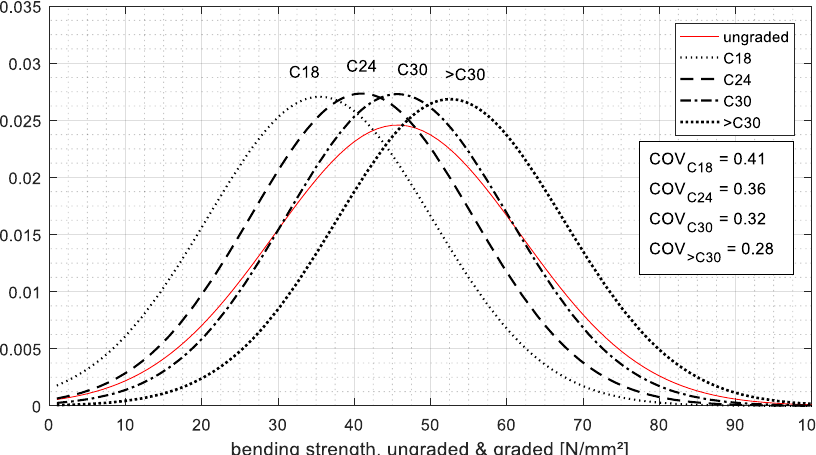
Figure 4. Probability density functions of graded and ungraded materials from the stochastic grading model for spruce samples and strength grading based on an indirect ultrasonic time-of-flight measurement.